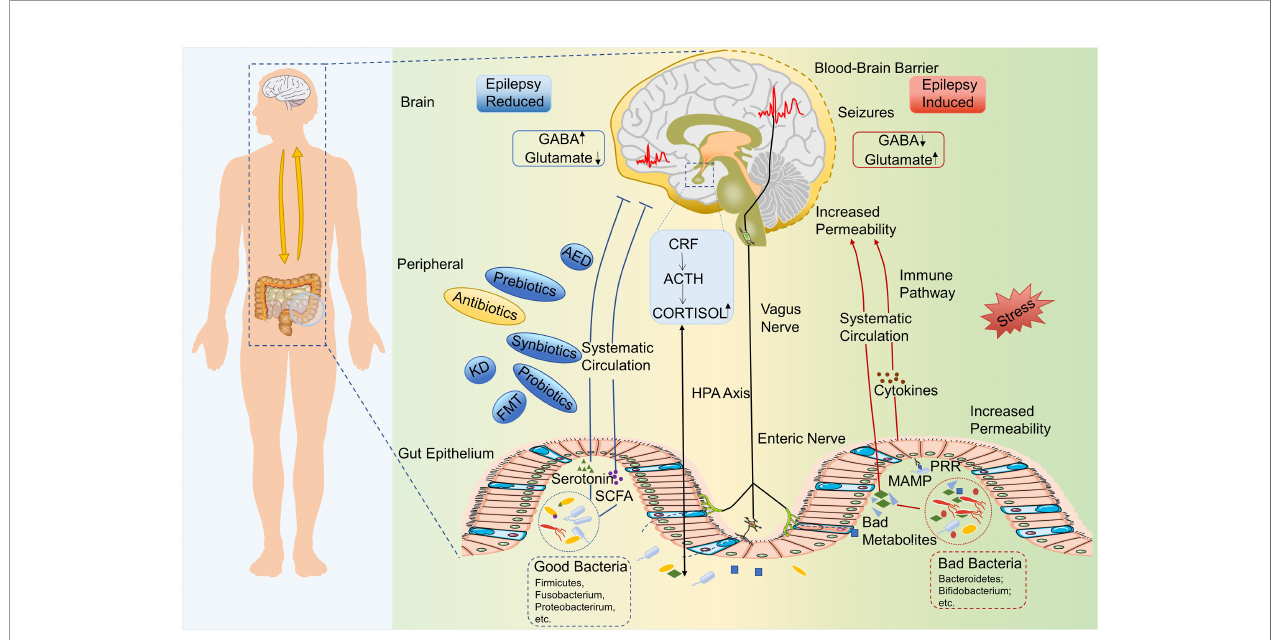
FIGURE 1 | The microbiota – gut – brain axis in epilepsy. Bad gut microbiota could upregulate the production of epilepsy-promoting metabolites, the secretion of in fl ammatory factors, and so on, which lead to abnormal GABA/glutamate ratio and then induce the epilepsy. Chronic stress may be a trigger for this process. Healthy gut microbiota could produce good metabolites, such as SCFAs and serotonin, which could inhibit the occurrence of epilepsy. HPA axis, enteric nervous system, and vagus nervous system are also involved in the interaction between gut microbiota and epilepsy. ACTH, Adrenocorticotropic hormone; AED, Antiepileptic drug; CRF, Corticotrophin-releasing factor; HPA, Hypothalamic – pituitary – adrenal; GABA, g -aminobutyric acid; KD, Ketogenic diet; MAMP, Microbe-associated molecular pattern; SCFA, Short-chain fatty acid; PRR, Pattern recognition